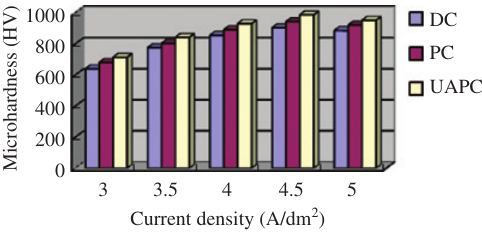
Figure 5 Plots of microhardness versus applied current density used for Ni-AlN thin film electrodeposition: DC, PC, and UAPC methods.